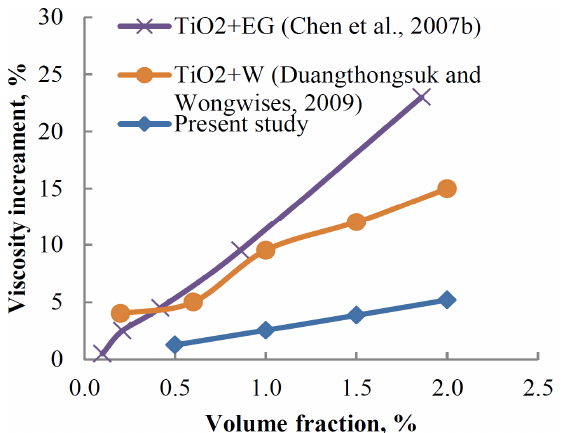
Figure 5. Increase in viscosity with the increase in particle volume fraction (W: Water, EG: Ethylene Glycol) [26].